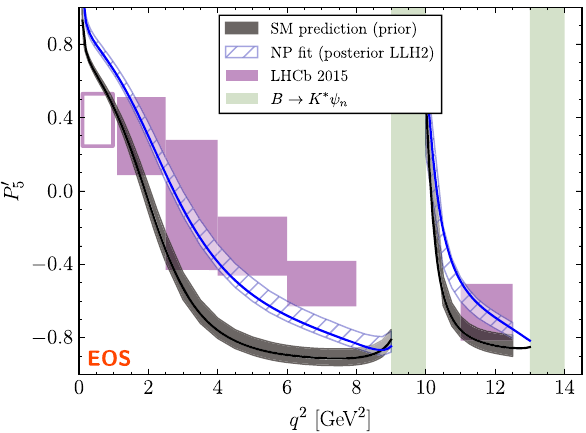
Fig. 2 Prior and posterior predictions for P (cid:16) NP C 9 benchmark, compared to LHCb